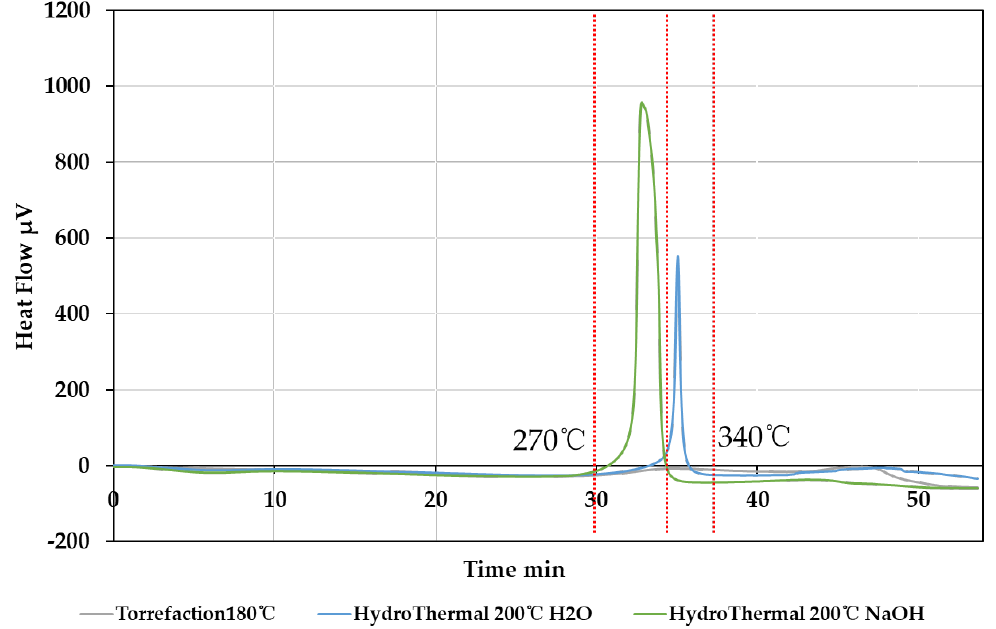
Figure 16. DTA analysis results of the rice husk torrefaction and hydrothermal products.